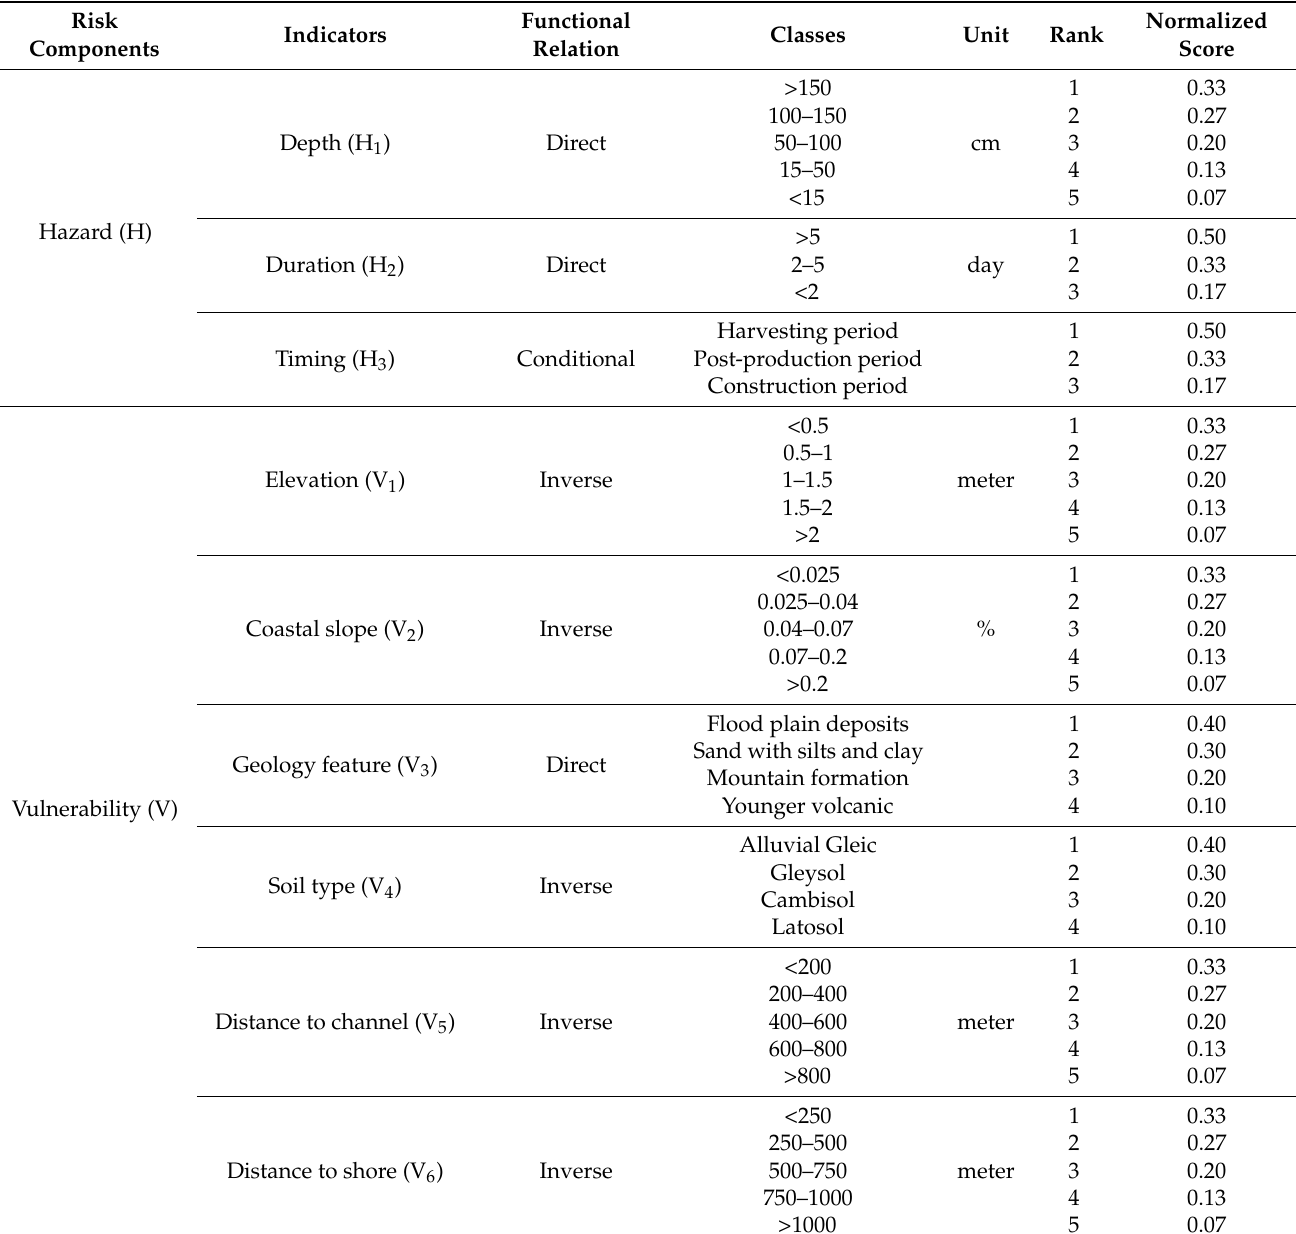
Table 2. Hazard and vulnerability components for the current study.